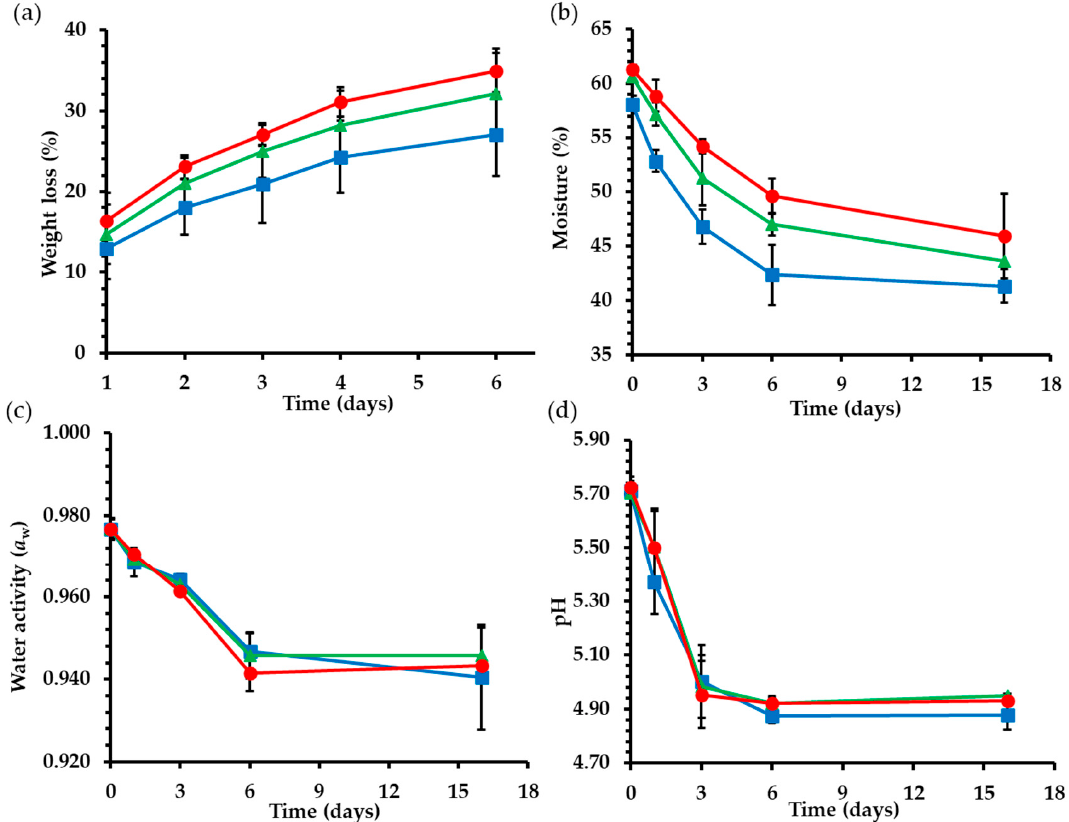
Figure 1. Weight loss % ( a ), moisture % ( b ), water activity (a w ) ( c ), and pH ( d ) during fermentation and ripening of fermented sausages. ( ■ ) Control: 18% pork backfat; ( ▲ ) SB60: 9% pork backfat and 9% B60 bigel; ( ● ) SB80: 9% pork backfat and 9% B80 bigel.